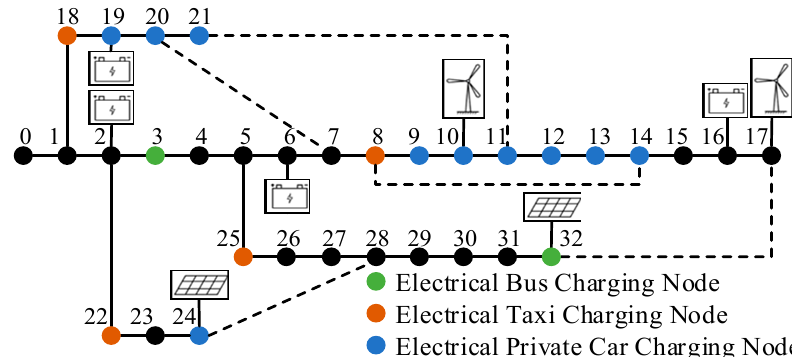
Figure 4. Grid structure of IEEE 33-bus system.